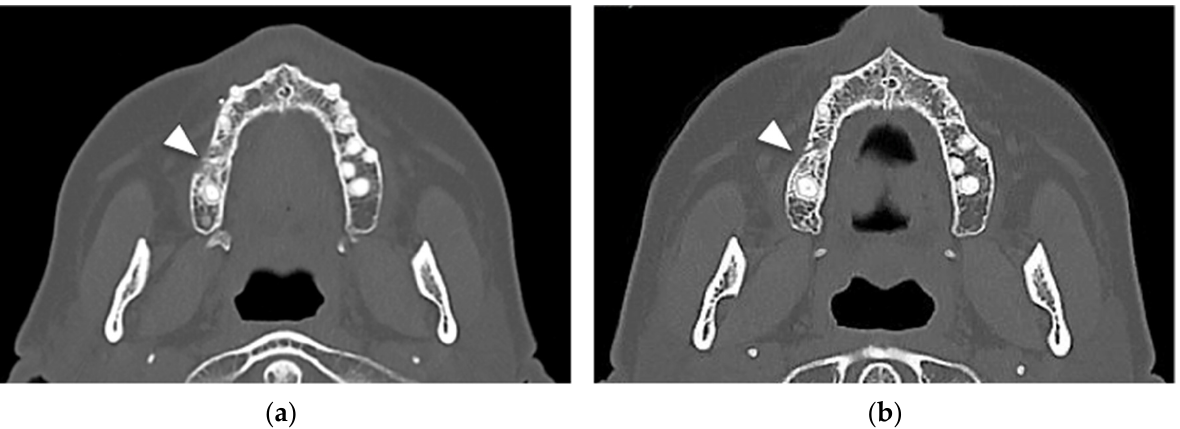
Figure 5. ( a ) Six-month post-operative CT axial scan with clear aspects of newly formed alveolar bone at the site of surgery (first right upper molar); a residual cortical interruption is maintained in the vestibular aspect without bone focal sclerosis (white arrowhead); ( b ) Axial CT at one year showing an almost complete continuity of the cortical bone with an alveolar crest width comparable to the contralateral site and resulting from bone repair (white arrowhead); the posterior region of the upper right jaw showed a regular bone architecture and trophism.